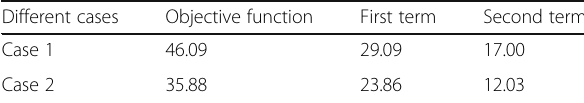
Table 4 The results of two cases